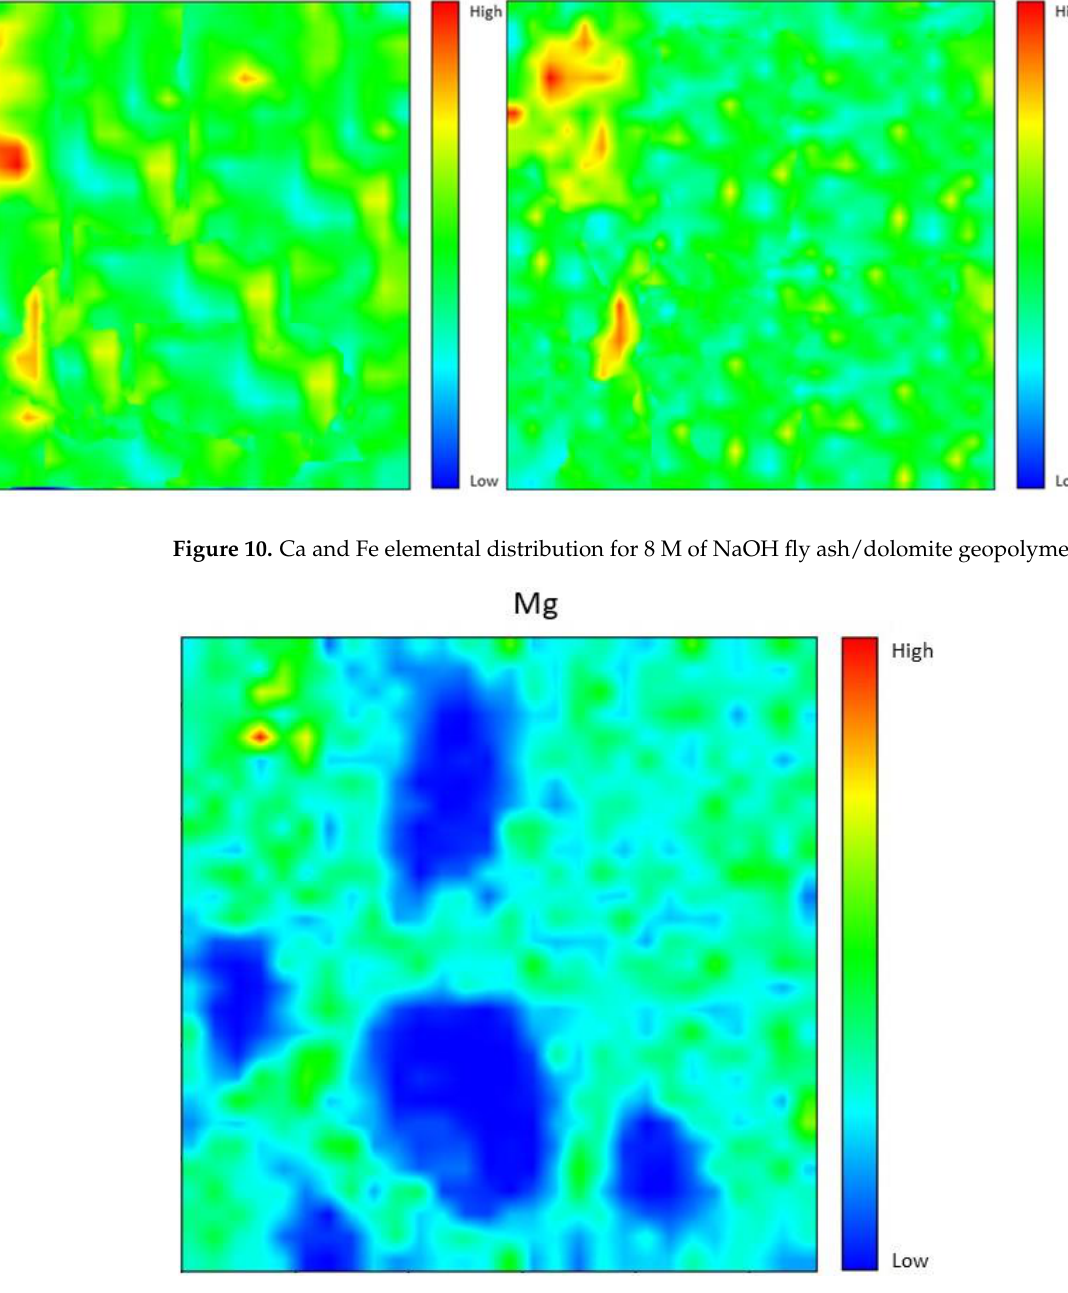
Figure 11. Mg elemental distribution for 8 M of NaOH fly ash/dolomite geopolymer. Generally, elemental distribution results show a good spread of elements all over the geopolymer samples and produced high strength geopolymer samples with 8 M concentrations. The geopolymer’s main structure consists of Si–O–Al, which clearly shows the importance of Si and Al elements in producing good strength development [32,34–36]. Well-distributed elements in the geopolymer composite samples indicated the production of a homogenous geopolymer composite. A homogenous mixture of geopolymer composites enhances the strength of the material. The combination of Ca, Si, and Al maps led to the formation of a calcium aluminate hydrate (C-A-S-H) phase which leads to the development of strength with self-hardening characteristics at room temperature